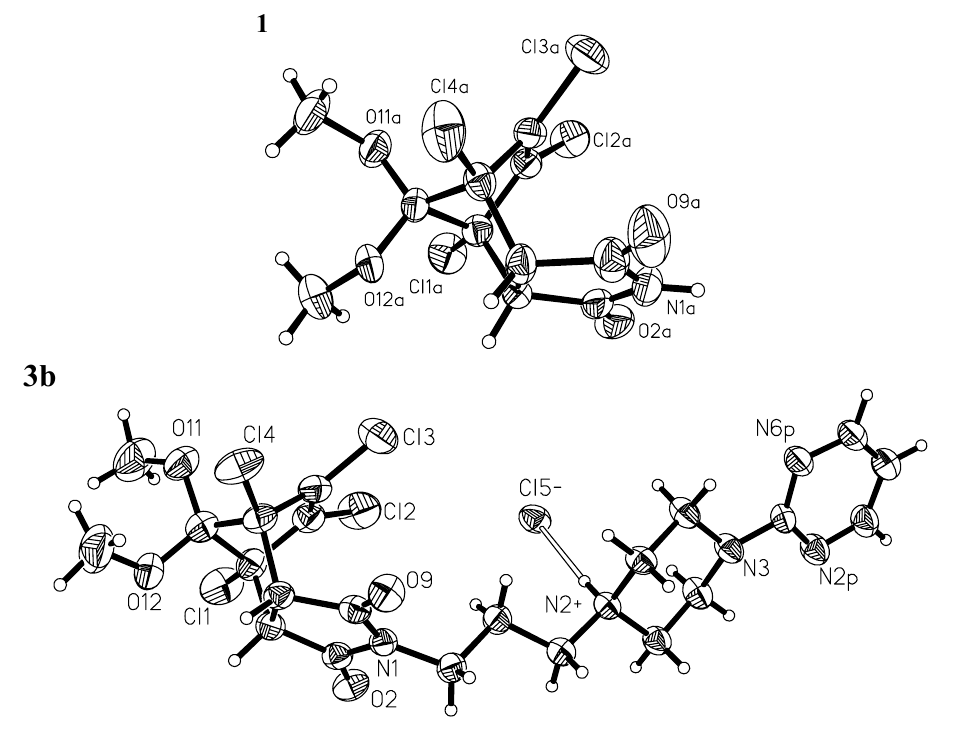
Figure 1. Molecular structures of compounds 1 and 3b